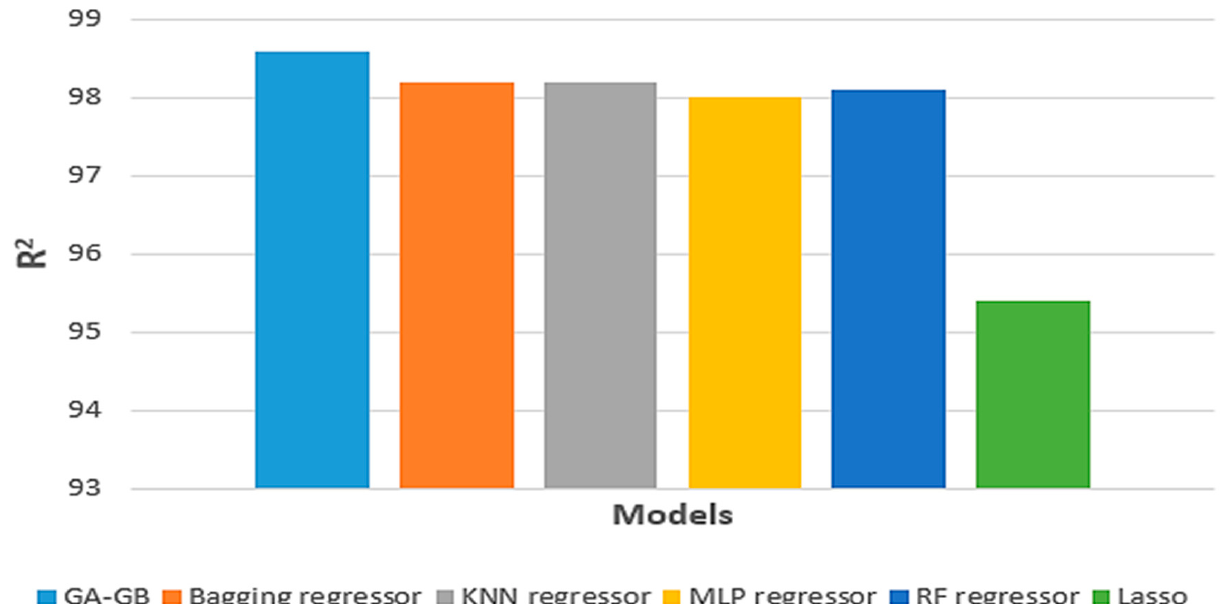
Figure 3. Comparison between the models used in the term of coefficient of determination ( R 2 ) using OPrice dataset.